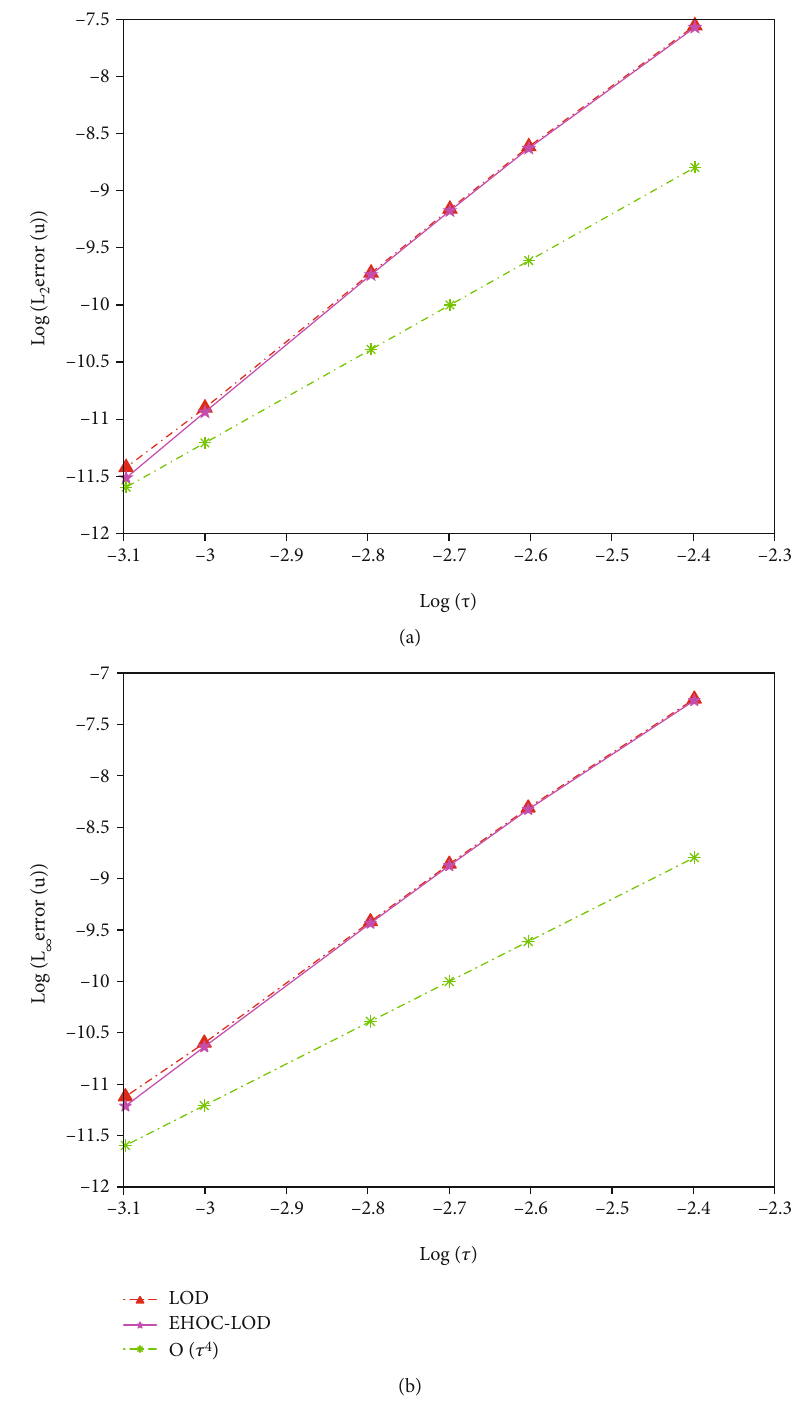
Figure 2: Log-log plots for the L